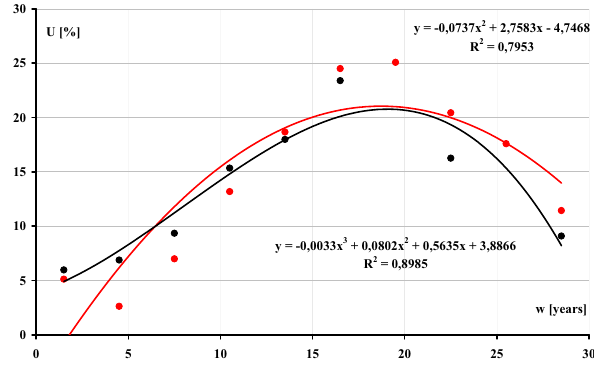
Figure 7: Dependence of the share of vehicles with faults among vehicles in a given age range for gasoline - powered vehicles ( red line ) and diesel fuel ( black line )